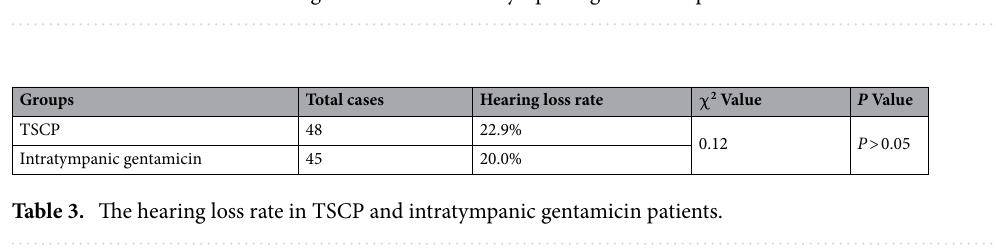
Table 2. The control rate of vertigo in TSCP and intratympanic gentamicin patients.